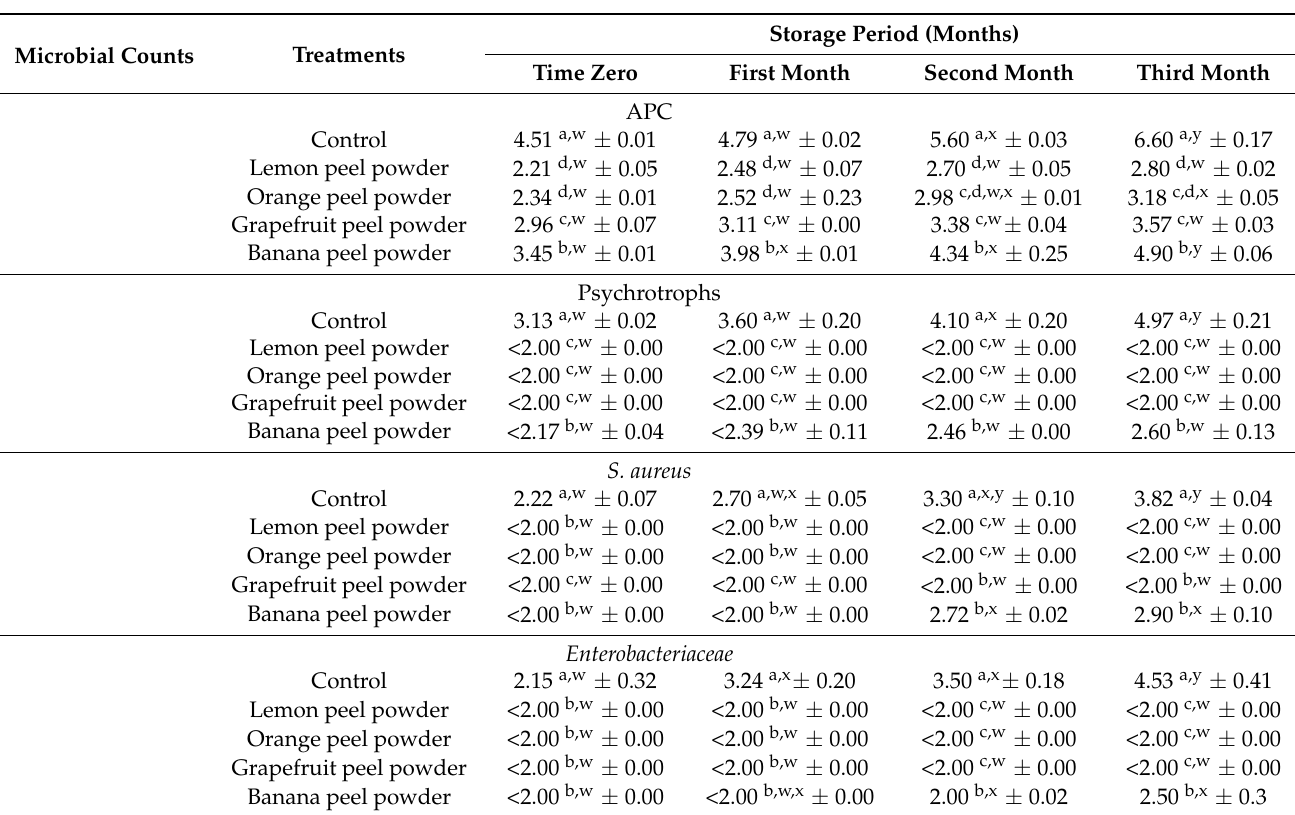
Table 2. Microbial counts (log 10 CFU/g) of chicken patties with the incorporation of different fruit peel powders (1%) during frozen ( − 18 ◦ C) storage for 3